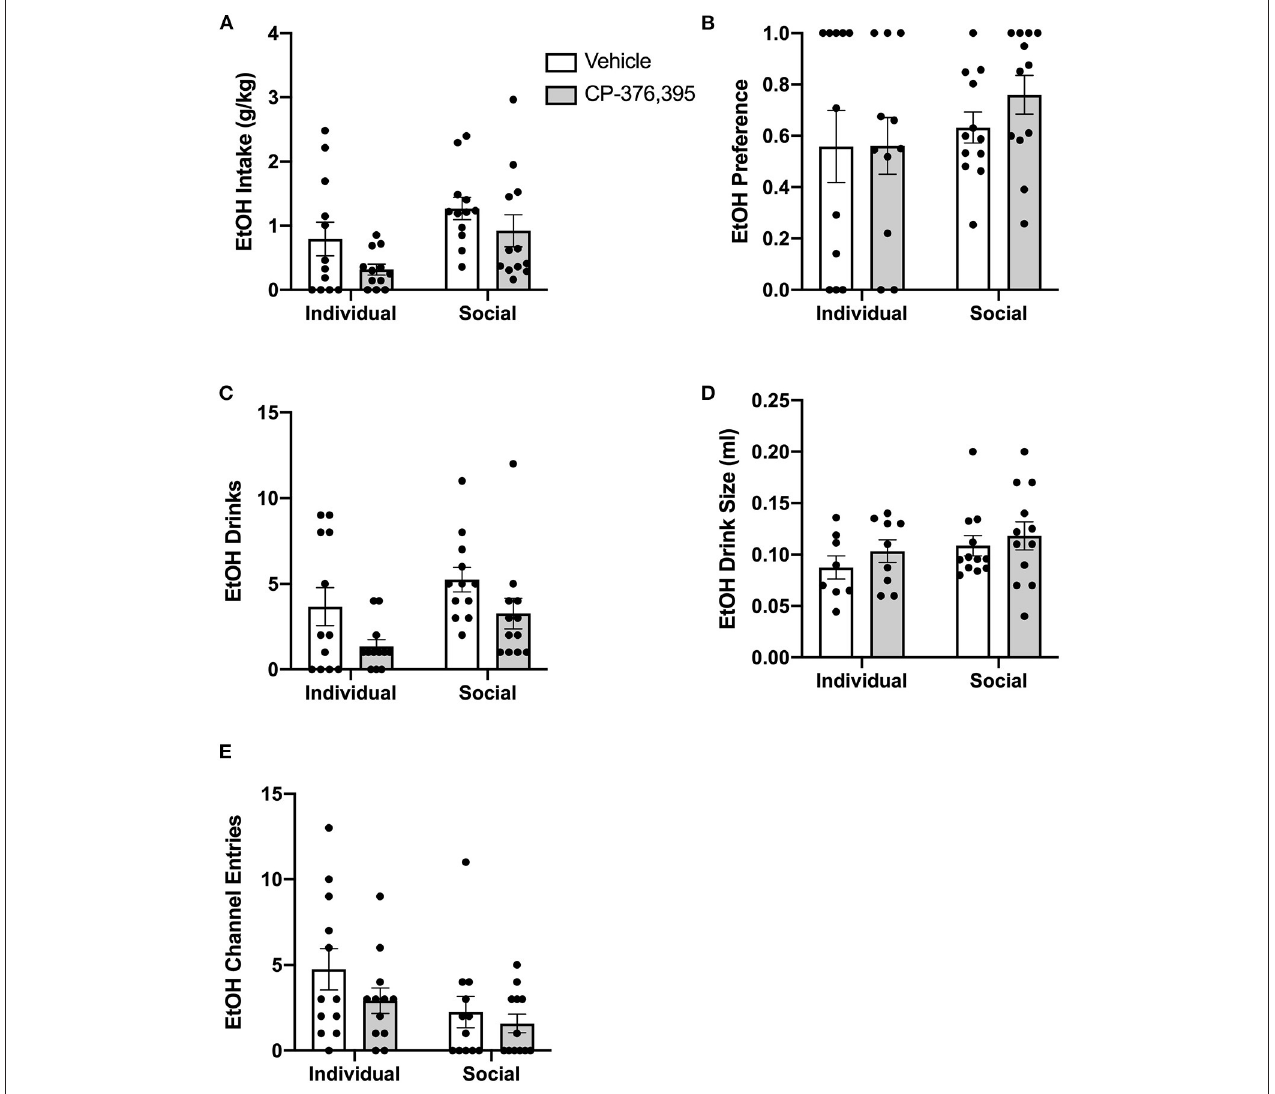
FIGURE 11 | Three hour cumulative ethanol data post-CRFR1 antagonism. (A) Ethanol intake in g/kg. (B) Ethanol preference. (C) Number of ethanol drinks. (D) Ethanol drink size in mls. (E) Ethanol channel entries. During the first 3 h post-treatment, CRFR1 antagonism caused decreases in g/kg ethanol intake and the number of ethanol drinks across both housing conditions, with ethanol preference, drink size, and channel entries remaining unaffected. Data represented as mean ± SEM. n = 12/group.